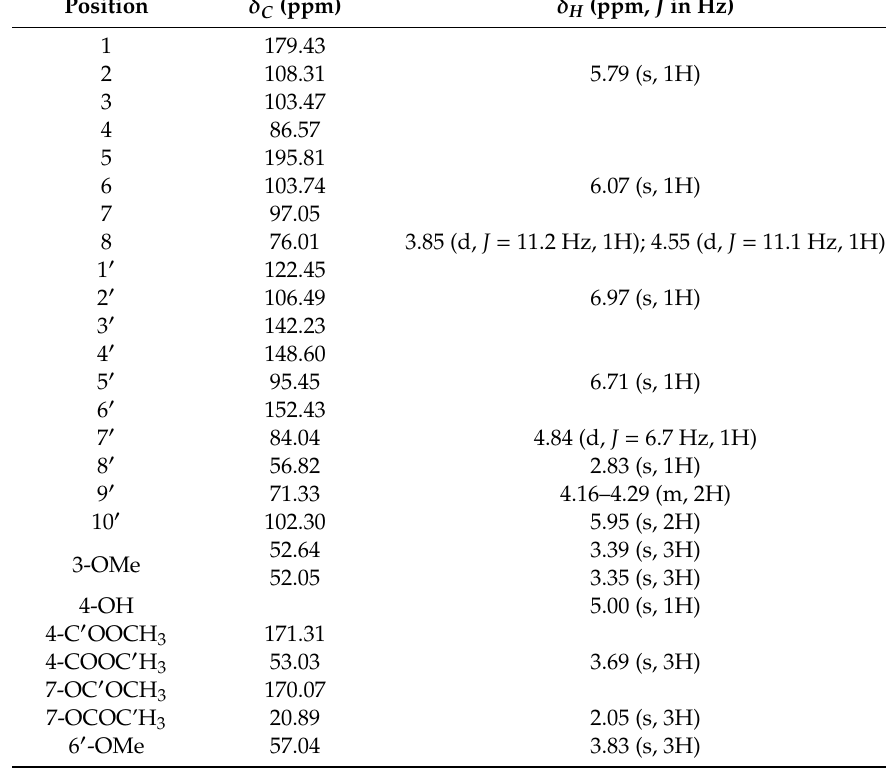
Table 1. 1 H-NMR (500 MHz) and 13 C-NMR (126 MHz) data of compound T4 measured in C 3 D 6 O. Position δ C (ppm) δ H (ppm, J in